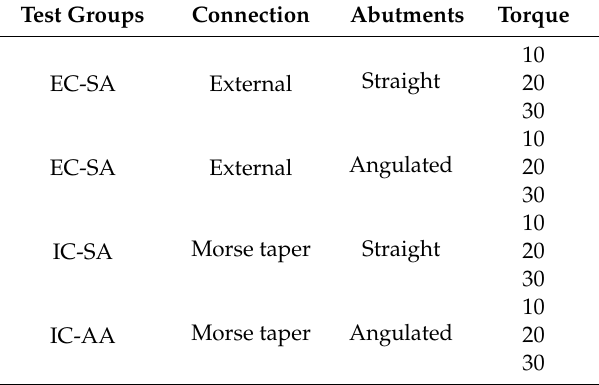
Table 3. Classification of the tested groups, according to the connection, the abutment and the torque load (Ncm) (EC: external connection; IC: internal connection; SA: straight abutment; AA: angulated